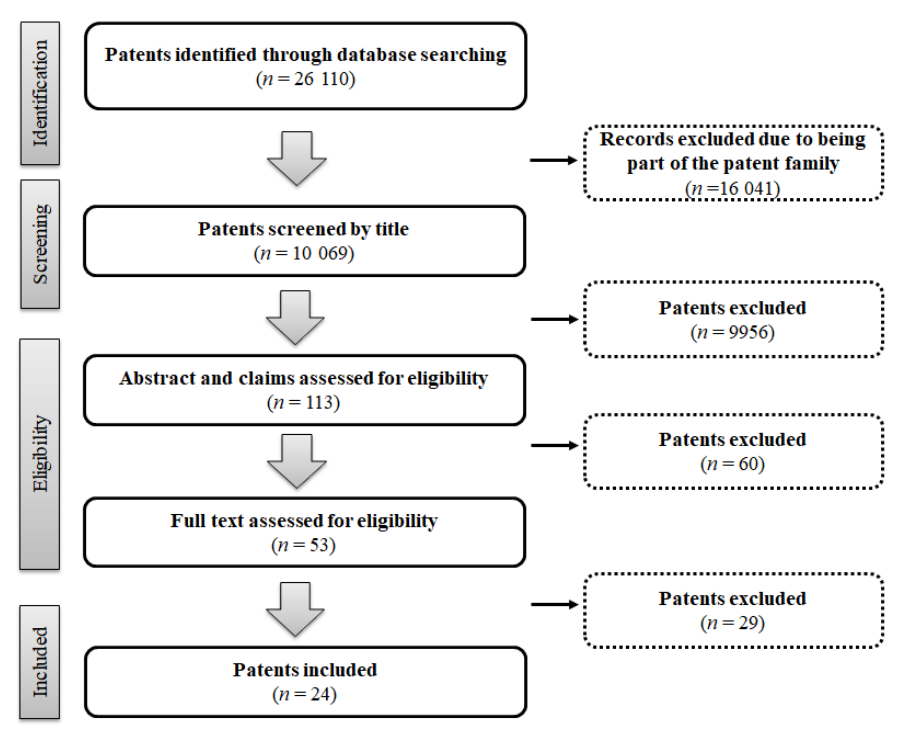
Figure 1. PRISMA flow diagram (adapted).